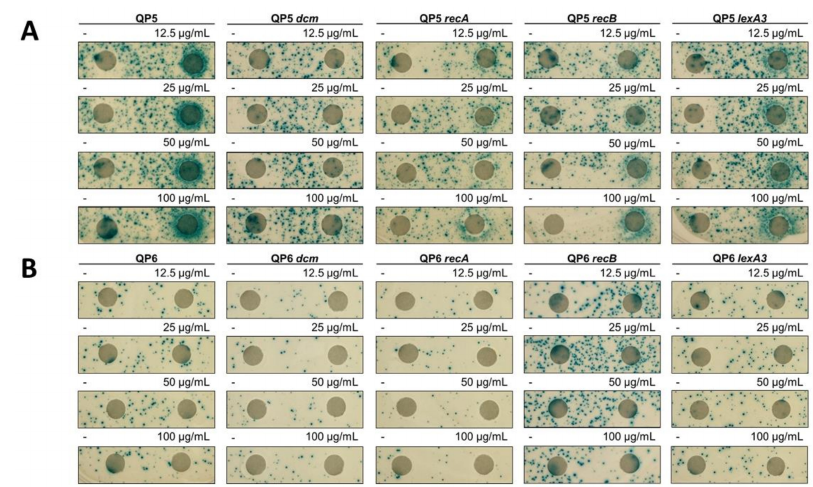
Figure 2. Mutator effect of 5-azacytidine. Disk diffusion assay for Lac reversion using QP5 ( A ) and QP6 ( B ) reporters ± dcm , recA , recB , lexA3 and lactose X-gal papillation medium. Each disk on the right was saturated with 5 µ L of 5-azacytidine at the indicated concentrations. The control disk on the left was spotted with 5 µ L of water.